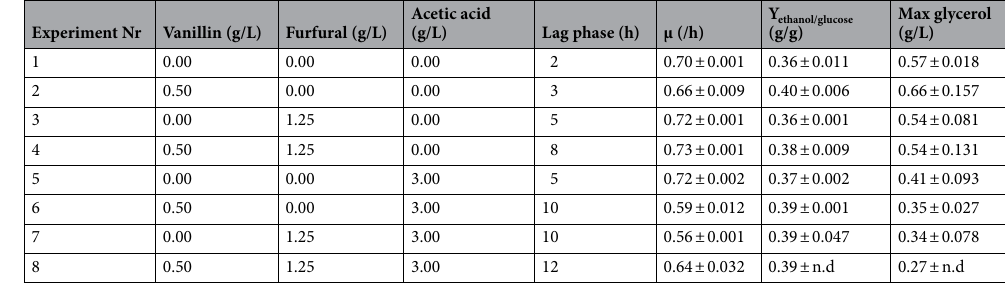
Table 1. Specific growth rate (µ), lag-phase, ethanol yield (Y ethanol/glucose ) and maximum glycerol concentration in experiments 1–8.